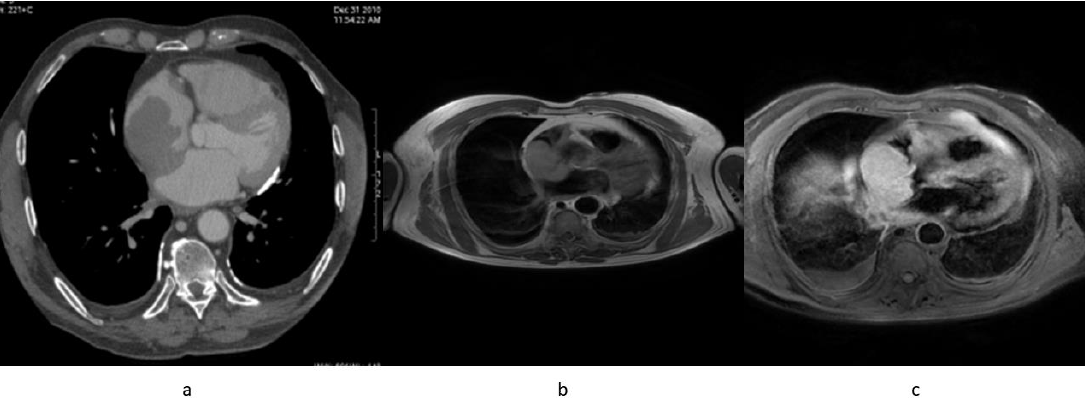
Figure 1. January 2020; ( a ) CT scan showing a right atrial mass hypointens after contast enhanced agent and apparent thickening of the left atrial wall; ( b ) MR with sequences BB T1, confirming the right atrial mass: ( c ) BBT1 delayed gadolinium images sequence showing a lesional delayed enhancement.